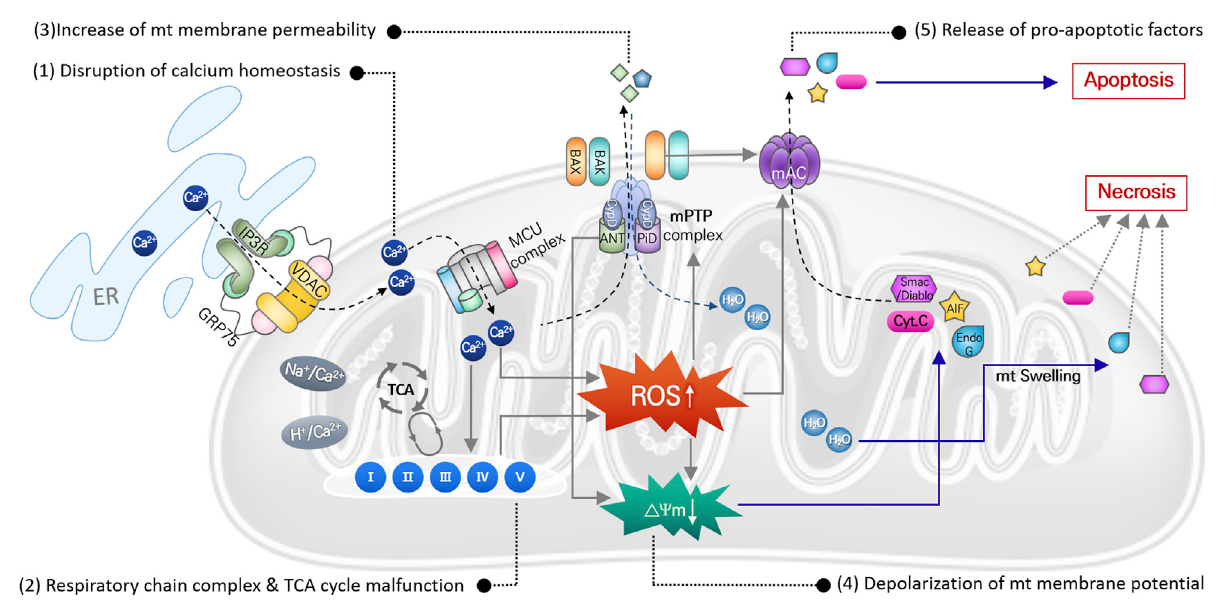
FIGURE 1 Noise, aging and ototoxic drug-induced intracellular signaling pathways leading to hair cell death. It indicates that organelle stress (ER and mitochondria), in fl ammation, MAPK signaling pathways induced by three environmental stimuli are all mutually interact each other, which fi nally leads to apoptosis or necroptosis of hair cells. Importantly, increase in mitochondrial ROS is at the center of all the